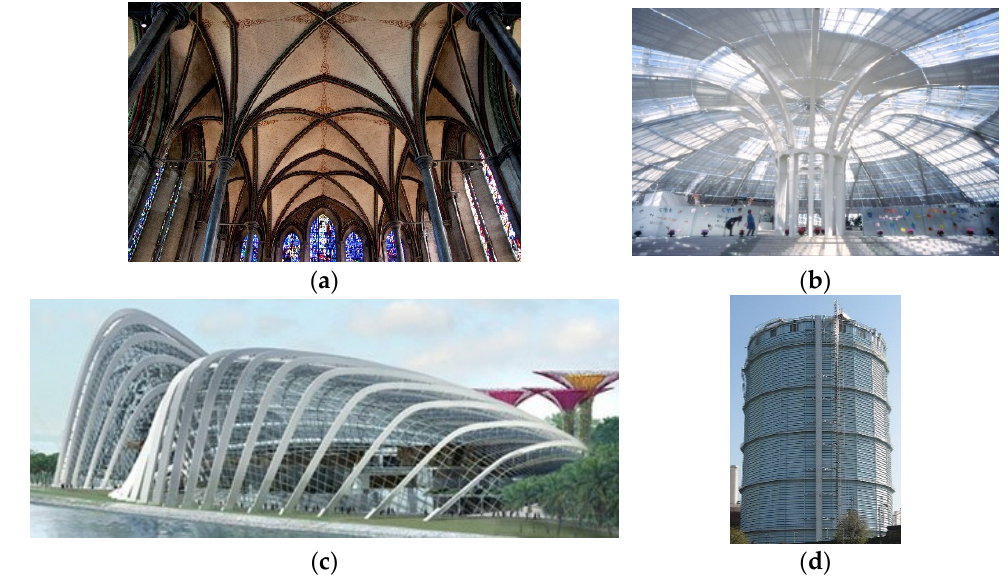
Figure 2. ( a ) Stiffened structures in the Salisbury cathedral (Photo by Tony Hisgett on Flickr (https://www.flickr.com/photos/hisgett/5690722283/, accessed on 8 September 2021)), ( b ) Yamanashi fruit museum (Photo by scarletgreen on Flickr (https://www.flickr.com/photos/9160678@N06/620307455/, accessed on 8 September 2021)), ( c ) garden at Marina South (Photo from eVolo (https://www.evolo.us/worlds-largest-climate-controlled-glasshouse-wilkinson-eyre-architects/, accessed on 8 September 2021)), and ( d ) gas holder (Photo by Richard Rogerson (https://commons.wikimedia.org/wiki/File:Gas_Holder_by_Battersea_Railway_Station_-_geograph.org.uk_-_1820717.jpg, accessed on 10 September 2021)).